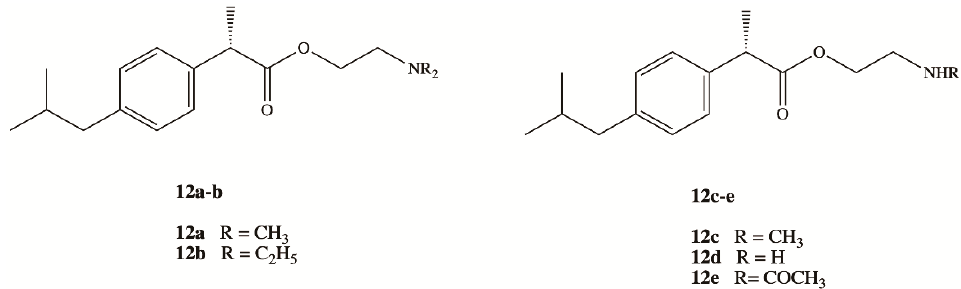
Figure 8. Dexibuprofen derivatives modified by ethanolamine related structures.